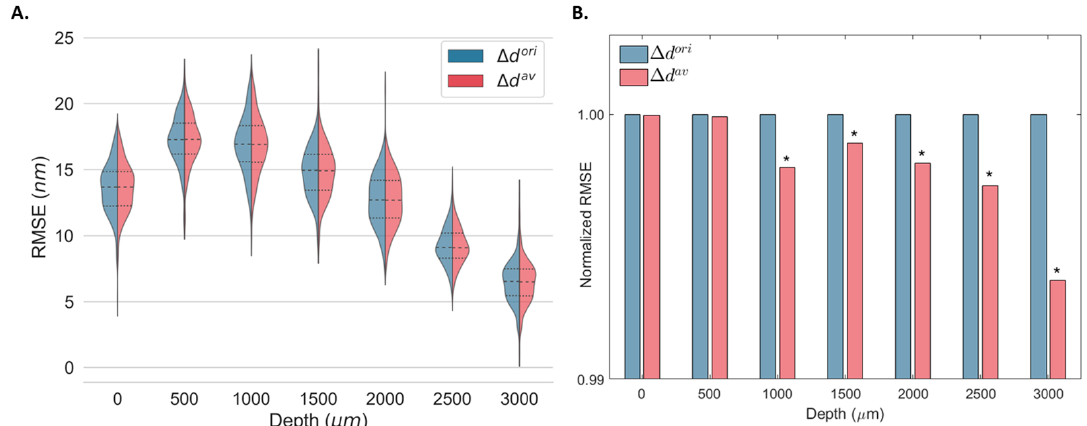
Figure 6. Kernel density estimates of the root-mean-square error (RMSE) displacement distribution for 256 depth locations ( A ) and mean normalized RMSE ( B ) of a static gold mirror at multiple optical path differences (OPD) using the original ( ∆ d ori ) and the proposed estimator ( ∆ d av ). The median (dashed) and the first and third quartiles (dotted) are shown. * Statistically significant at p < 0.001. The minimum detected displacement at different OPDs was obtained from σ ∆ and σ ∆ at 256 different locations using Equation (1) (Table 2). For OPDs equal to and ϕ av greater than 1000 µ m, an improvement in the accuracy of the displacement estimation was achieved using ∆ d av estimation. Improvements between 0.01% and 0.37% were observed depending on the imaging depth. No significant changes were observed for optimal SNR (OPD = 0 µ